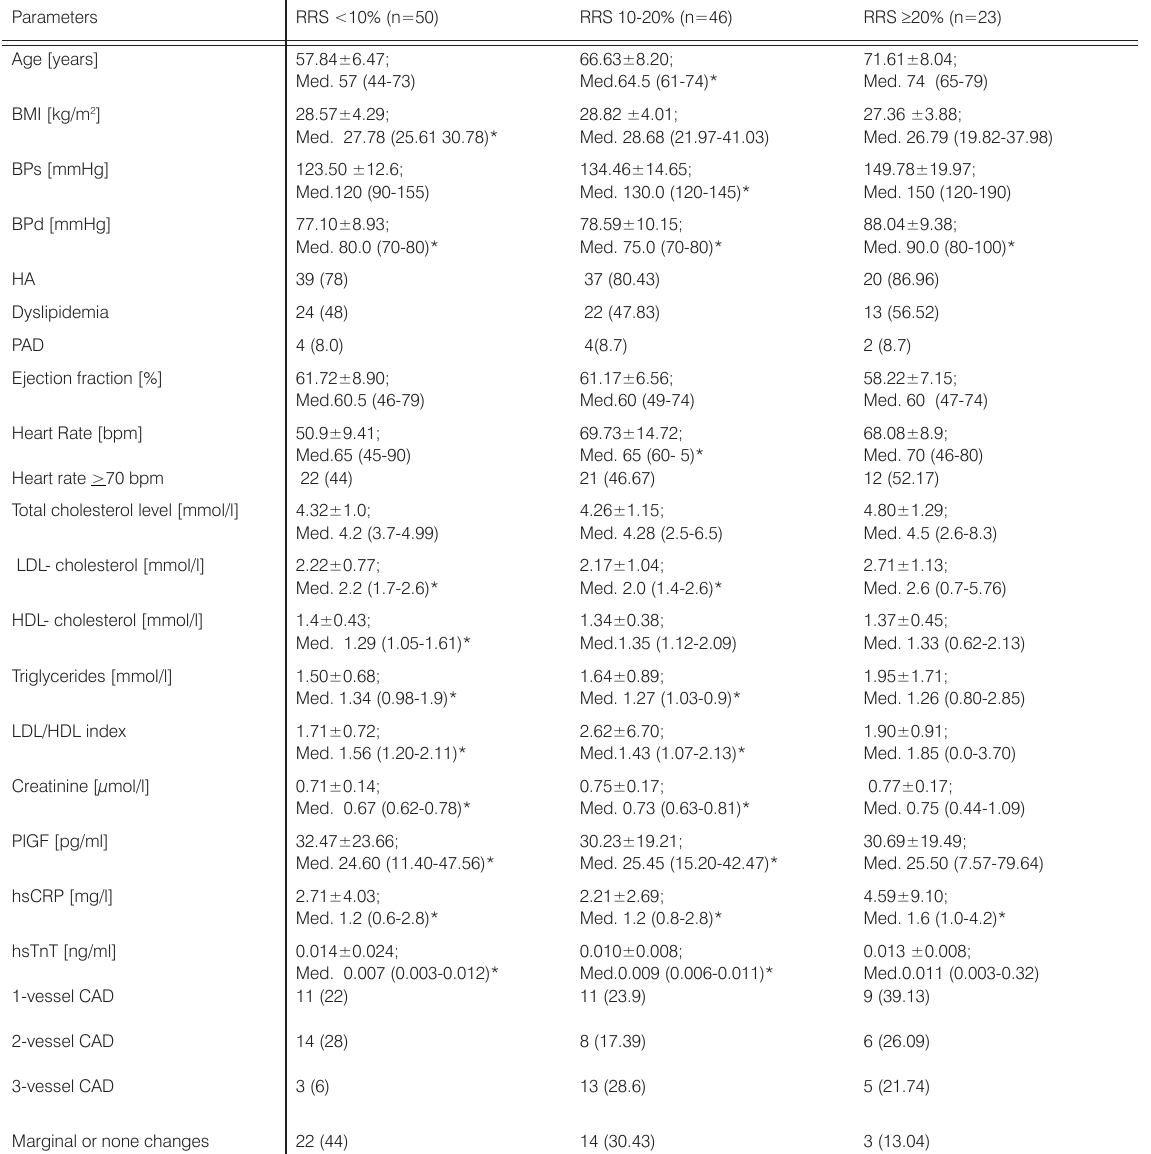
Table 2. Patients characteristics related to Reynolds Risk Score (RRS).